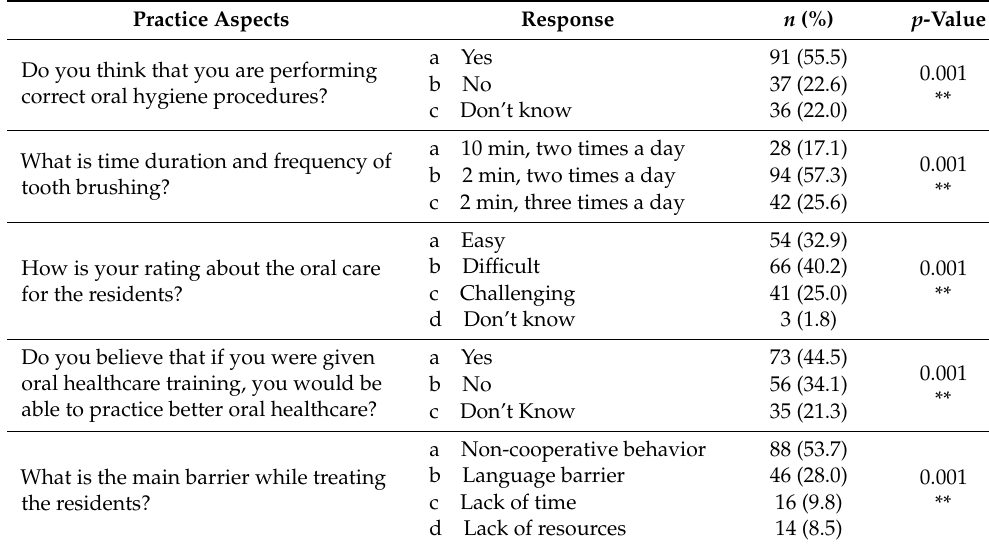
Table 4. Distribution of responses related to practice among